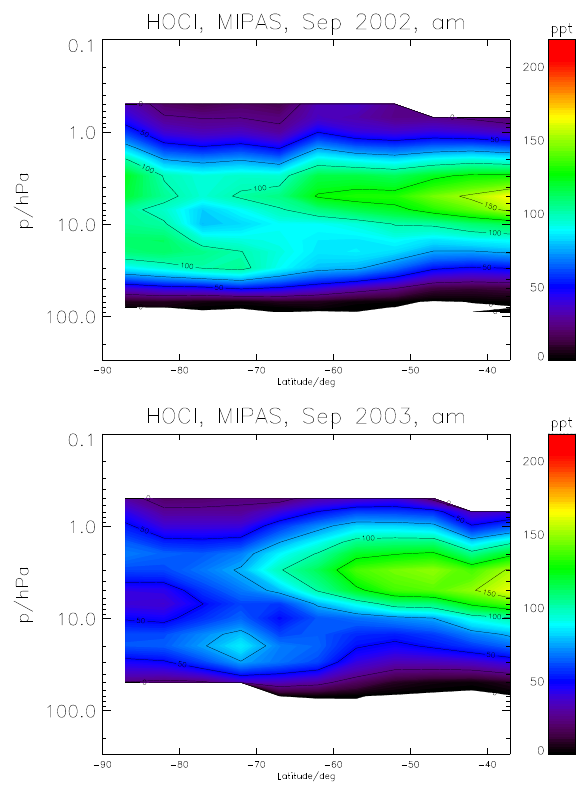
Fig. 9. Large HOCl amounts in the upper southern polar vortex are found in the southern winter 2002 (upper panel) when unusual planetary wave activity led to displacement, deformation, and split of the polar vortex, but not in 2003 (lower panel) when the polar vortex behaved normally. HOCl September zonal mean values of the descending part of the orbit, i.e. morning measurements, are shown.